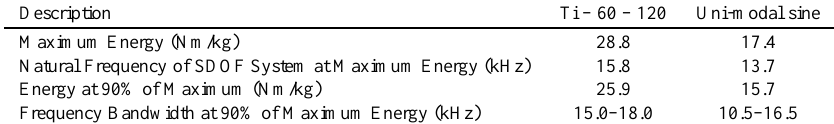
Table 3 Energy input for the VAMP and uni-modal sine pulse acceleration signals